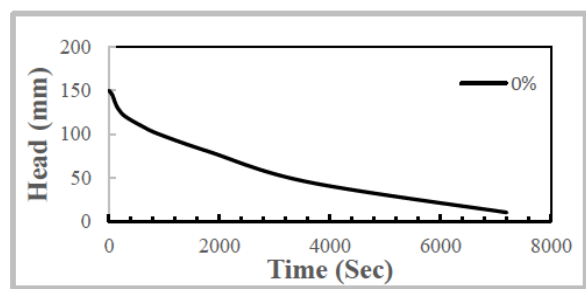
Figure 5: Horizontal deformation versus shear stress under 40 kPa of normal loading